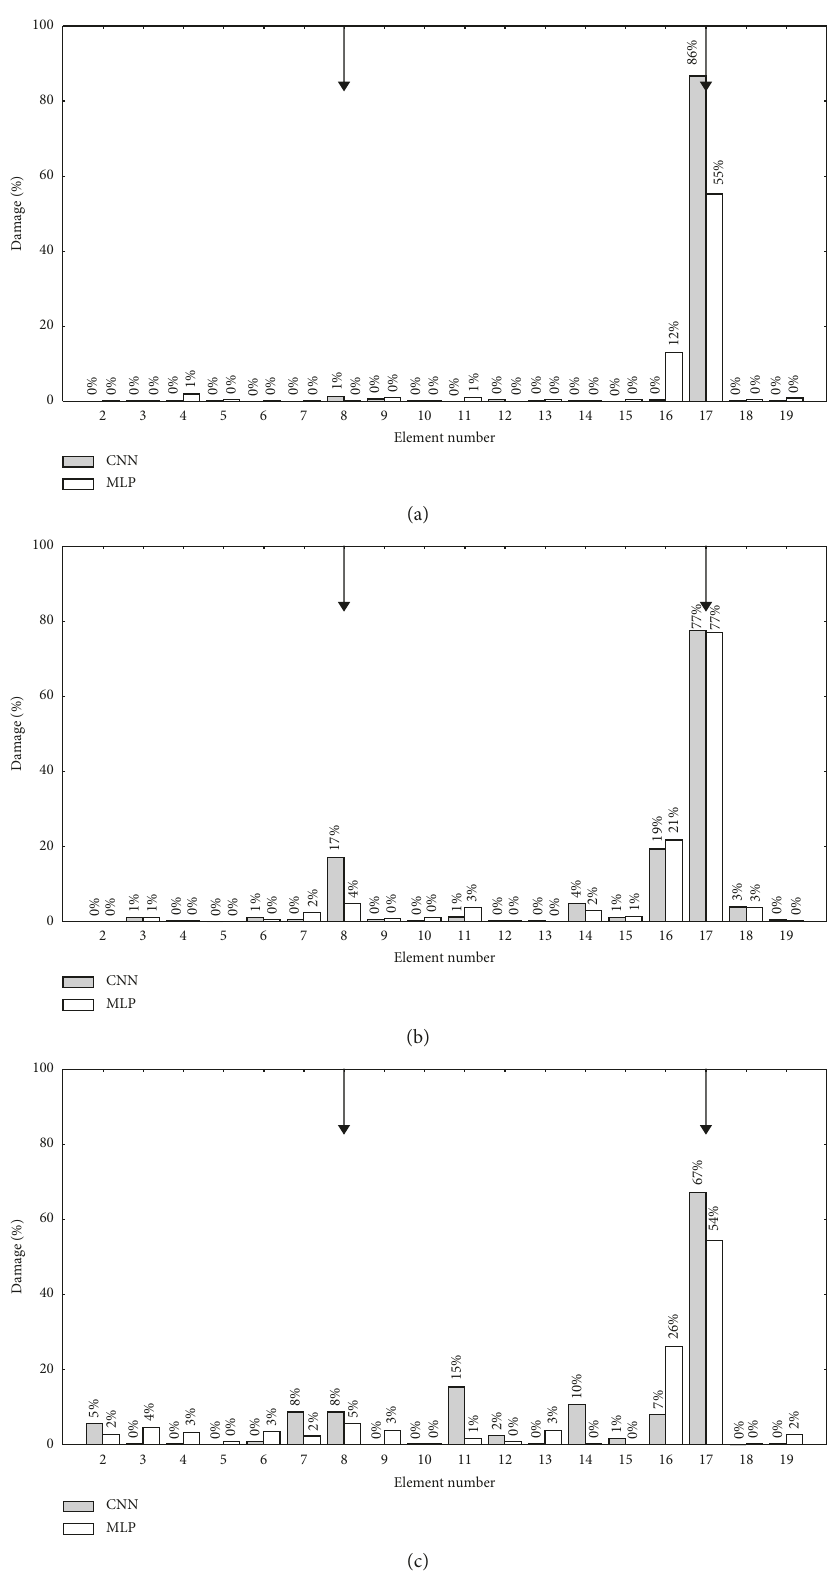
Figure 23: Results for damage scenario 3 according to (a) CNN and MLP models 1, (b) CNN and MLP models 2, and (c) CNN and MLP models